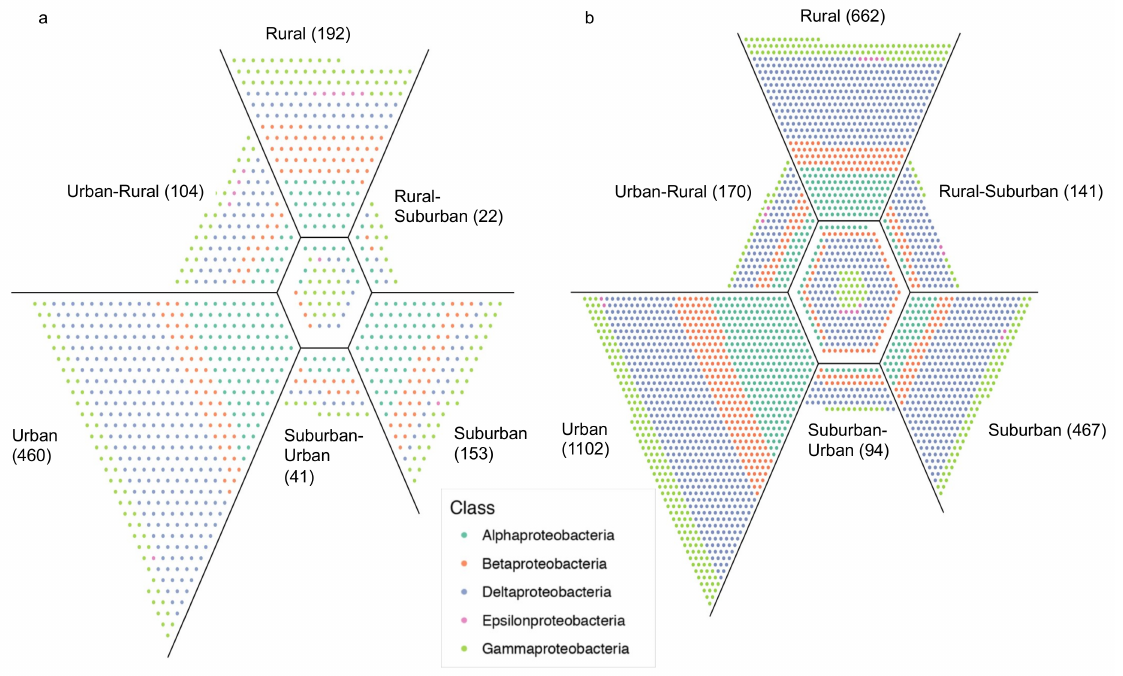
Figure 3. Venn-like representation of overlap between ASVs at urban, suburban, and rural sites for the phylum Proteobacteria. Each point represents an individual ASV with colors corresponding to different classes of Proteobacteria. Numbers in parenthesis indicate the total number of unique ASVs at each site. The center hexagon contains ASVs shared by all sites, while the trapezoids contain ASVs either exclusive to each site or those shared between two of them. In Buenos Aires (a) there were 45 ASVs shared by all sites and in Washington D.C. (b) 280. The plots were created using the unionplot R package